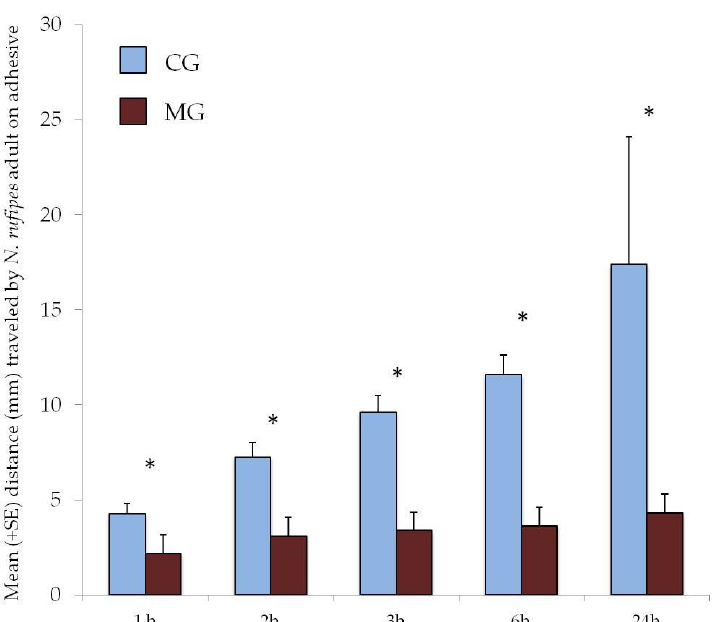
Figure 1. Mean distance (mm + SE) traveled by Necrobia rufipes adult on cockroach glue (CG) and mouse glue (MG) bases. The means were calculated considering only the retained adults (not considering the escaped ones); therefore, for CG base, n = 30 (1 h), 29 (2 h), 27 (3 h), 25 (6 h), 5 (24 h); and for MG base, n = 30 (1 h, 2 h, 3 h, 6 h, 24 h). * = p ≤ 0.001.